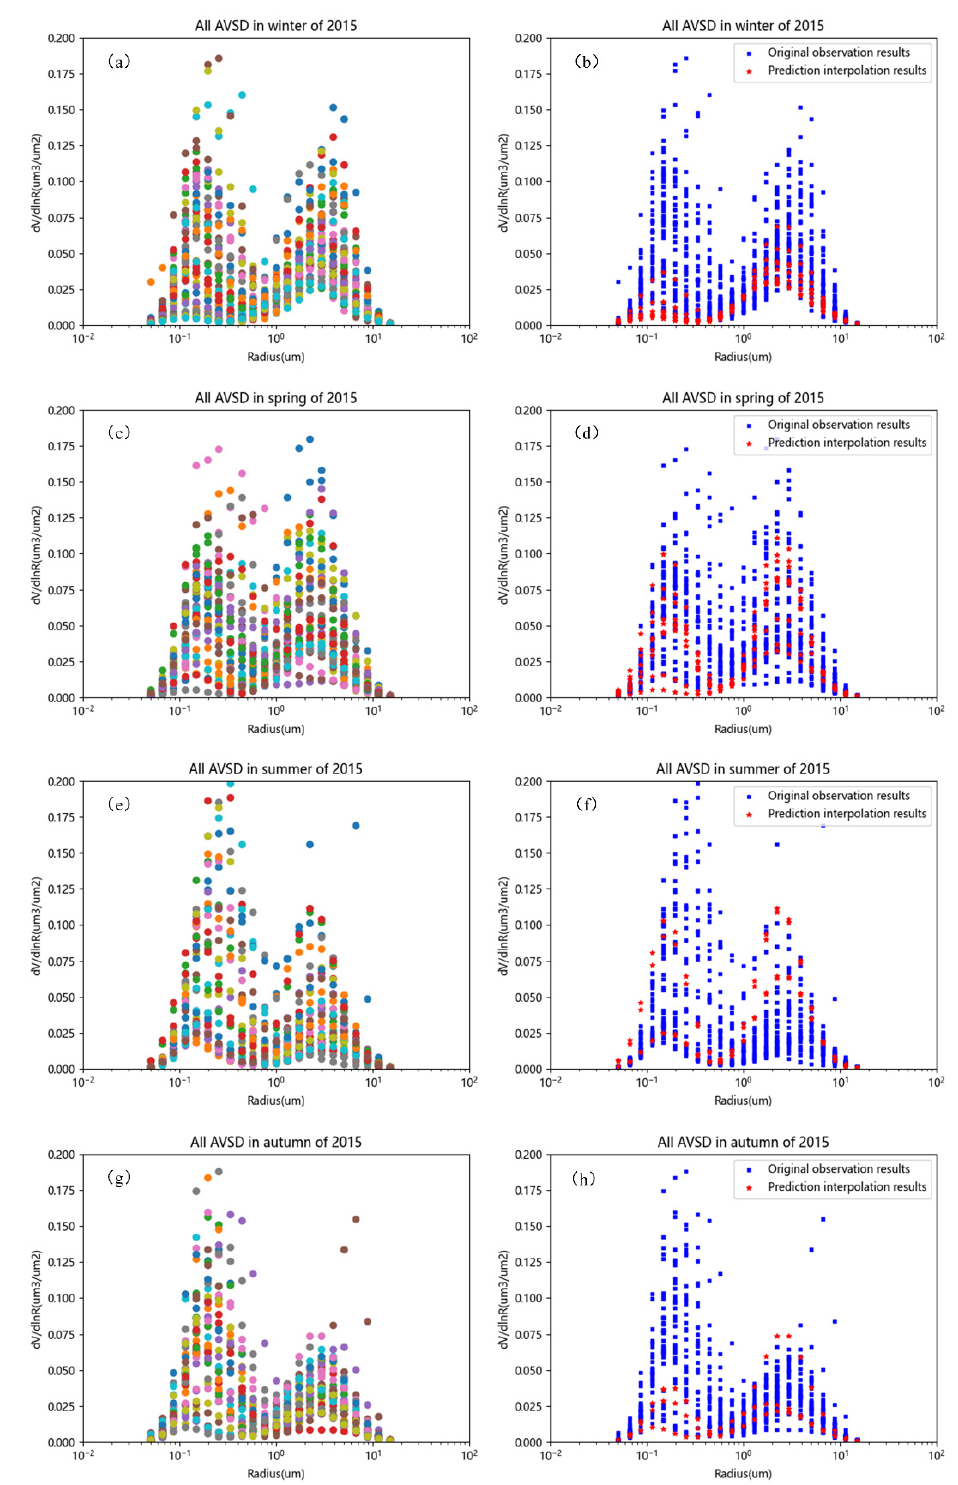
Figure 7. The interpolation results of the final inversion results. ( a ) All columnar AVSD obtained in winter include columnar AVSD obtained from original observations and columnar AVSD filled by model inversion, with different colored dots representing columnar AVSD of different dates; ( b ) all columnar AVSD obtained in winter are divided into two categories, with blue squares representing columnar AVSD obtained from original observations and red pentagrams representing columnar AVSD obtained from model inversion (same below); ( c , d ) all columnar AVSD obtained in spring; ( e , f ) all columnar AVSD obtained in summer; ( g , h ) all columnar AVSD obtained in autumn;. Although we obtained the missing columnar AVSD through model inversion and interpolated them to enrich all columnar AVSD data for each season, the data observed